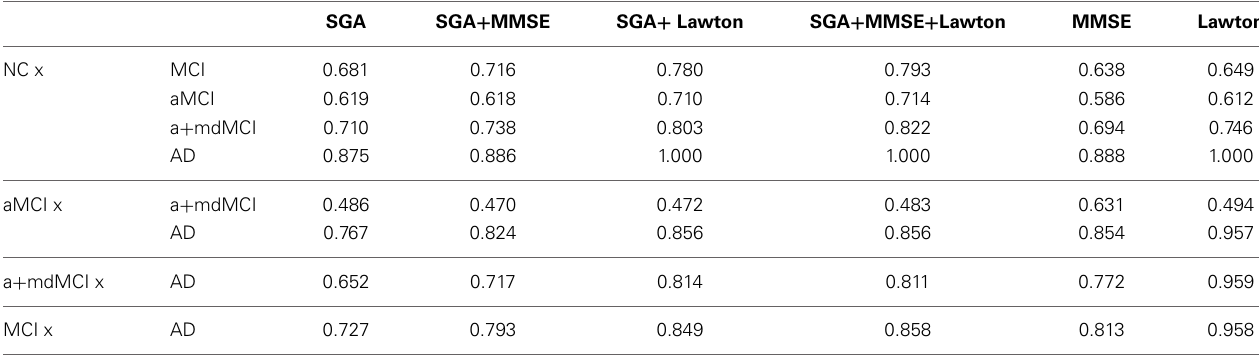
Table 5 | Rating quality measured by AUC, using SGA (attributes: WC, N, E, Density, Diameter, and ASP) correlated with clinical symptoms measured with MMSE and Lawton scales, in addition with Lawton, MMSE or both, classifying AD and MCI from NC, AD from MCI, and also classifying subtypes of MCI (aMCI or a + mdMCI) from NC or AD, or from each other.